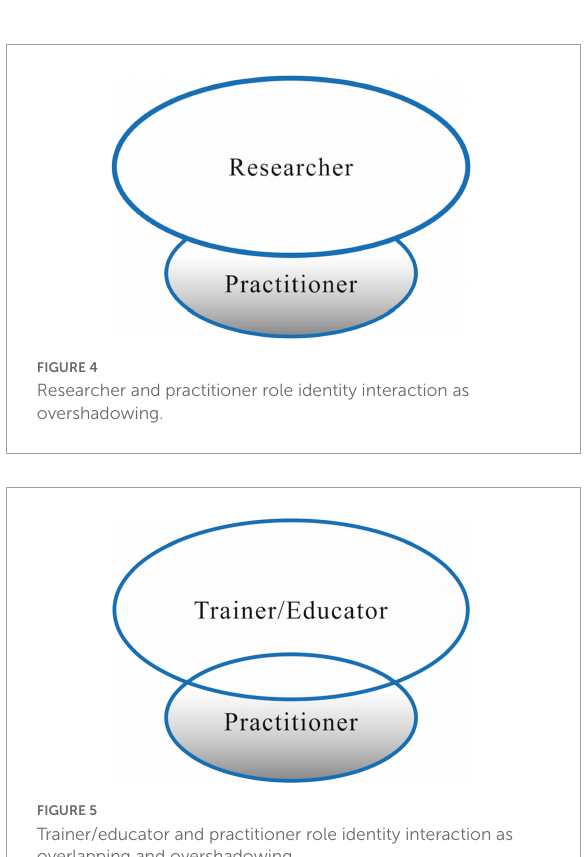
FIGURE5 Trainer/educator and practitioner role identity interaction as overlapping and